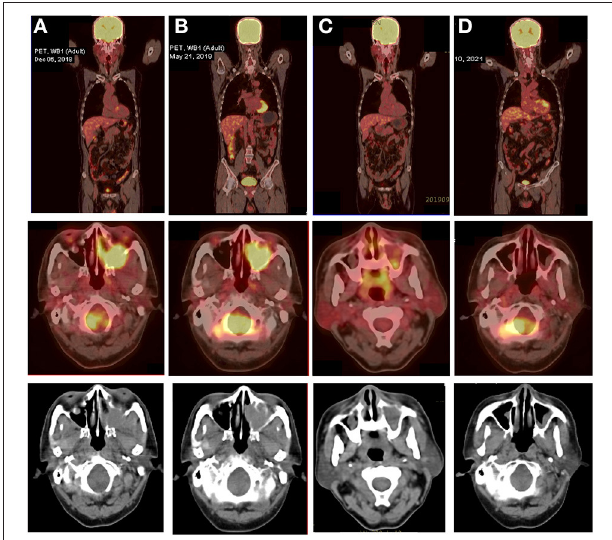
FIGURE 3 | 18 F-FDG PET/CT images of the PBL patient at various stages of treatment. (A) Transverse PET/CT scan showed a markedly FDG-avid mass at the left maxillary sinus that invaded the left nasal cavity, left orbital apex, and left alar mandibular space at diagnosis (SUV max , 7.8; SUV mean , 6.3). (B) After five cycles of V-CHOP, re-evaluating PET/CT showed diminished range of lesions to 3.8cm × 2.9cm × 3.8cm and reduced 18 F-FDG uptake in the left maxillary sinus (SUV max , 7.0; SUV mean , 4.5) and other locations (SUV max , 4.0; SUV mean , 3.6). (C) After local radiotherapy and two cycles of RV-CDOP, PET/CT showed a complete metabolic response (cMR) with a diminished range of lesions to 1.0cm × 1.3cm and significantly reduced 18F-FDG uptake in the left maxillary sinus (SUV max , 3.5; SUV mean , 2.5) and a lack of metabolic activity in other regions. (D) Follow-up PET-CT 16 months post ASCT showed continued